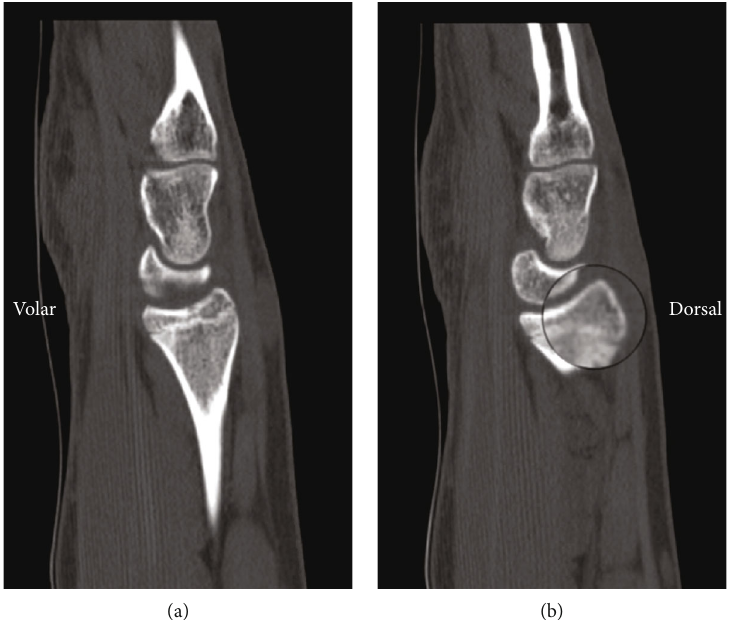
Figure 3: Sagittal CT view showing intra-articular extent of the fracture through the dorsal rim of the radius with interval healing.